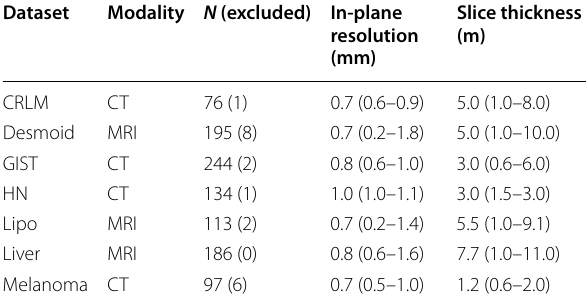
Table 1 Datasets used in the